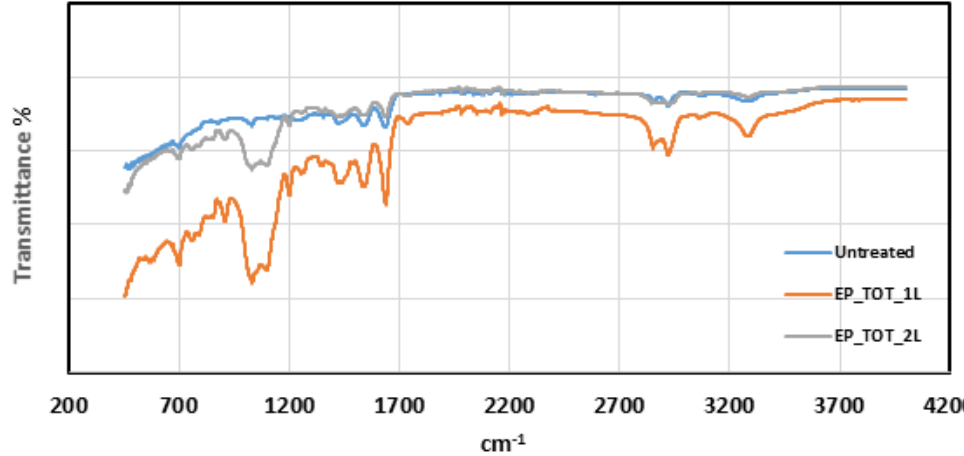
Figure 5. FTIR on untreated and (3-Glycidyloxypropyl)trimethoxysilane (EP) treated PA12-CR substrates .